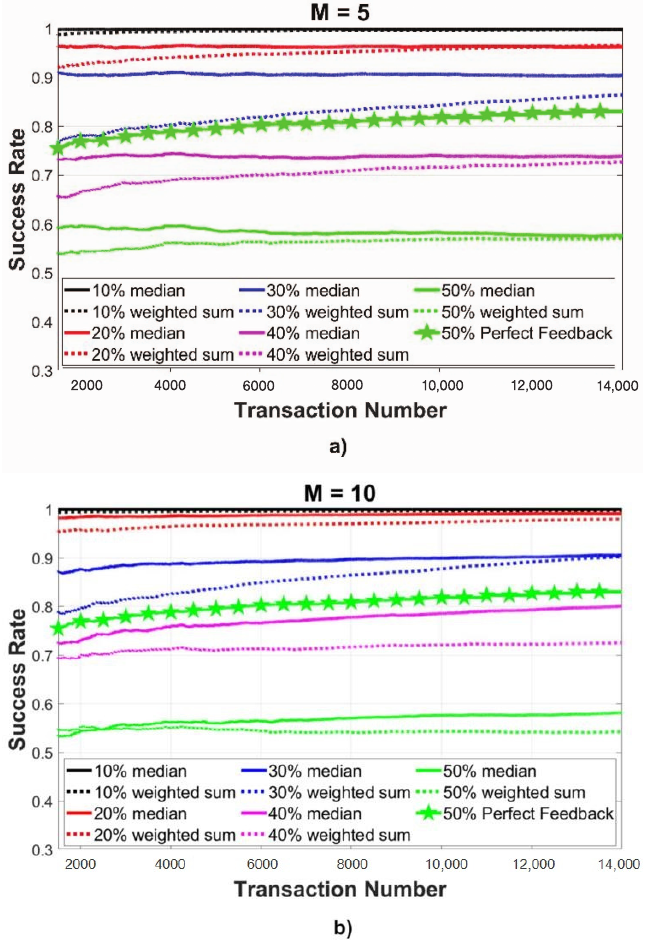
Figure 4. Transaction success rate at increasing values of % of malicious nodes, with M = 5 ( a ) and M = 10 ( b )